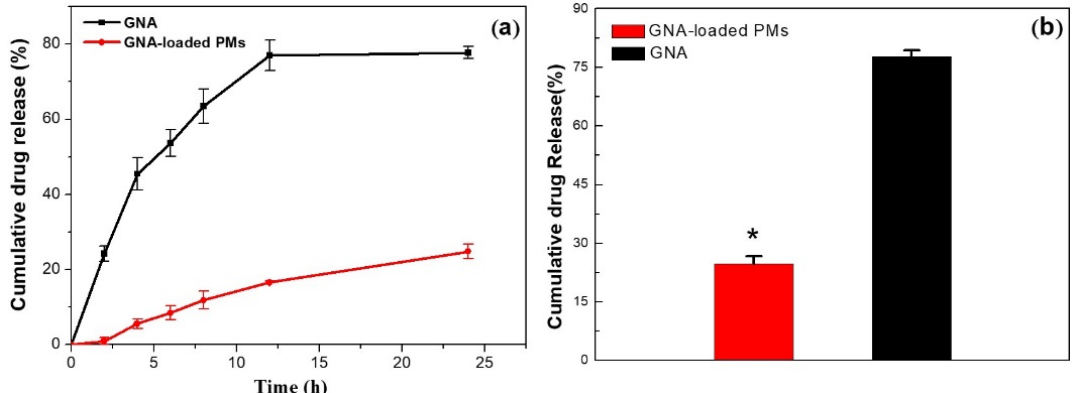
Figure 5. In vitro release studies of GNA from PMs. ( a ) GNA cumulative release in PBS at pH 7.4; ( b ) total release of different GNA formulation after 24 h. * p < 0.05. (Mean ± S.D., n = 3).